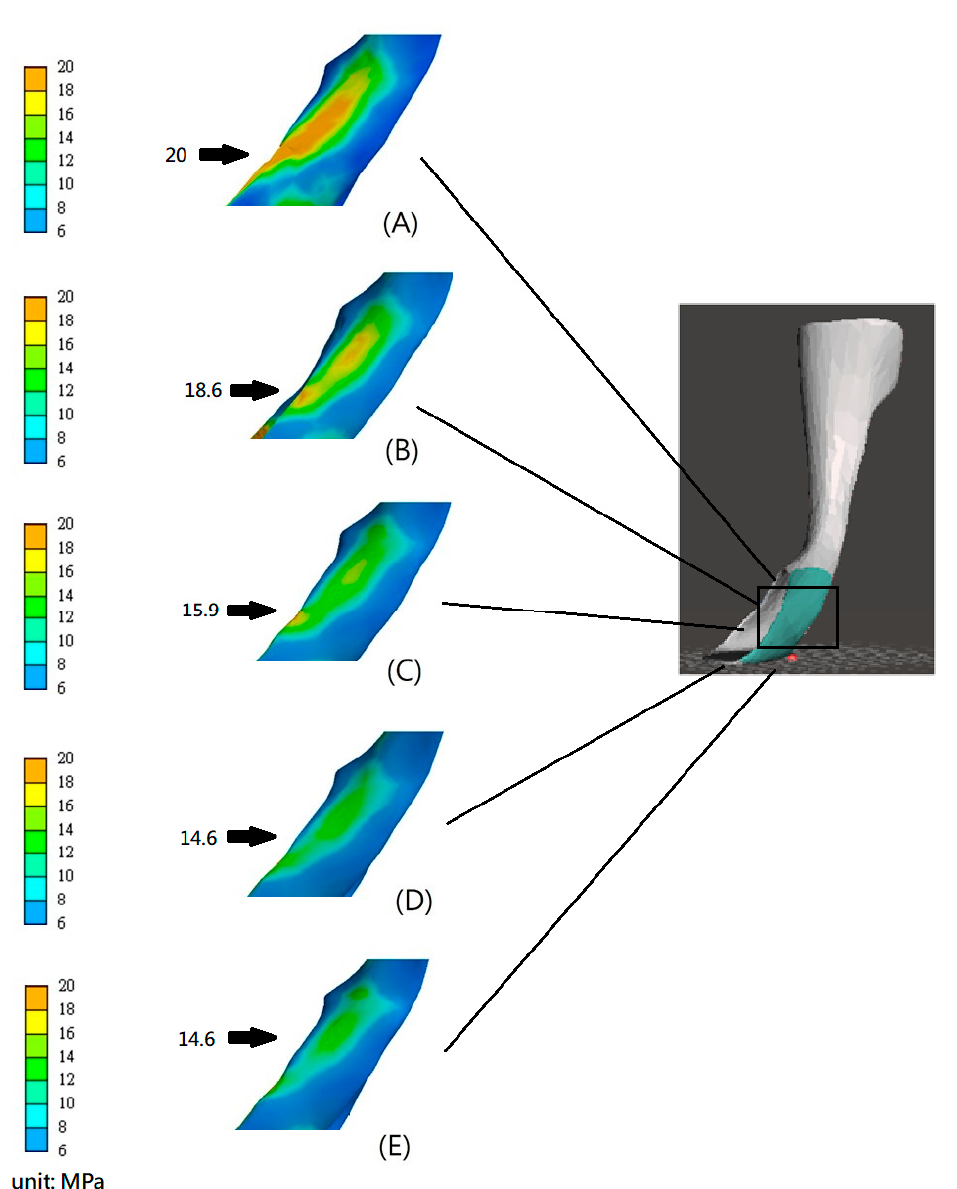
Figure 7. Stress distribution of the 3DP-AAFOs with different thicknesses around the neck in plantarflexion ( A ) 3.2 mm, ( B ) 3.7 mm, ( C ) 4.2 mm, ( D ) 4.7 mm, and ( E ) 5.2 mm. Note: Arrows indicate the location of the maximum stress.